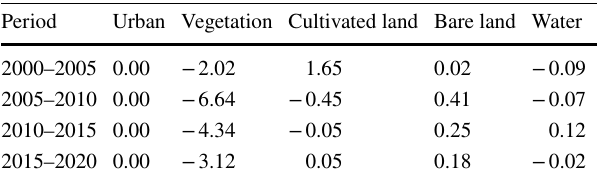
Table 7 Changes in ESV in the Shengli coalfield over 5-year